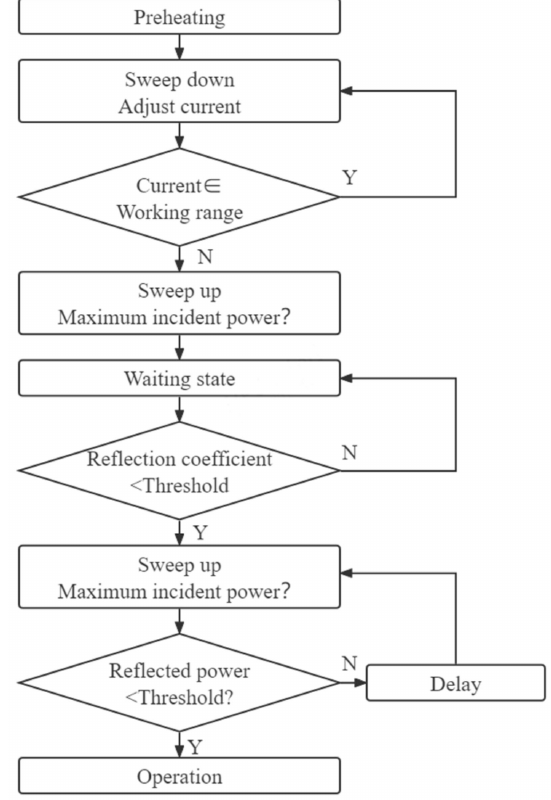
Figure 8. Control flow chart of the preheating